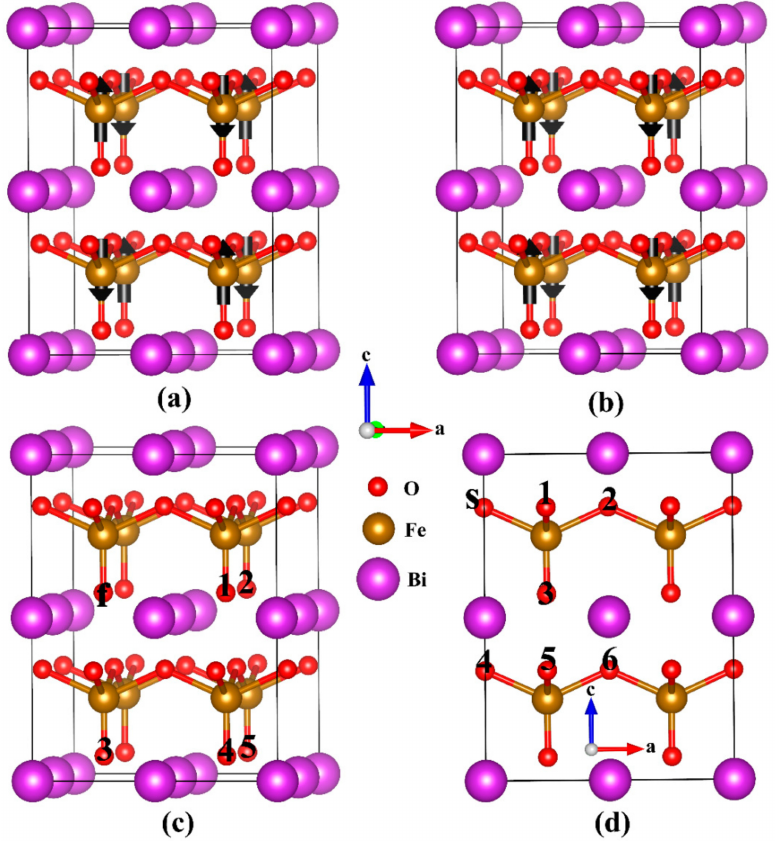
Figure 1. The 2 × 2 × 2 tetragonal BiFeO 3 (BFO) supercell used in our simulations. ( a ) G-antiferromagnetic (AFM) and ( b ) C-AFM spin arrangements. ( c , d ) The non-equivalent configurations as two nitrogen (N) atoms were placed on two oxygen (O) sites in the supercell. The arrows on the iron (Fe) ions indicate the spin arrangement. O atoms that will be substituted by N atoms are denoted by